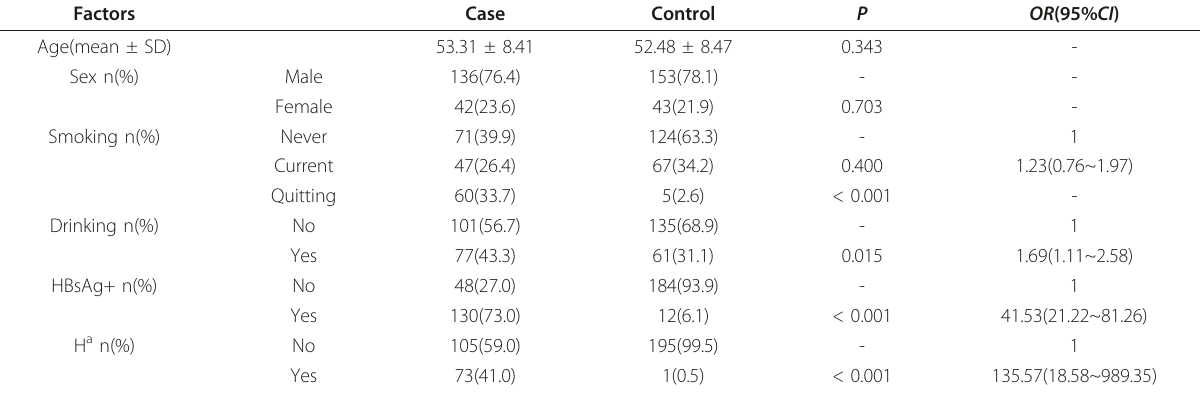
Table 2 General characteristics of the cases and controls